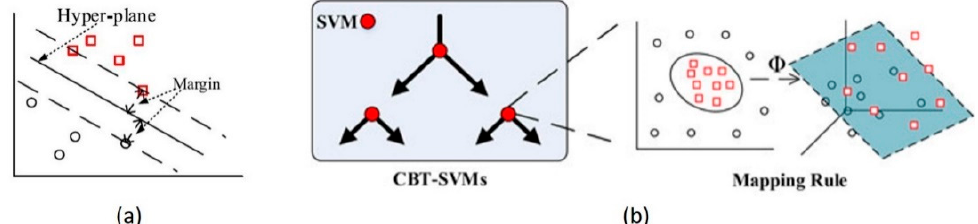
Figure 17. ( a ) Basic SVM classifier. ( b ) Complete binary tree structure multi-classes SVMs and mapping rule for PAM4 signal where the black circle and the red square represent two categories (reprinted from [40] with permission from IEEE).